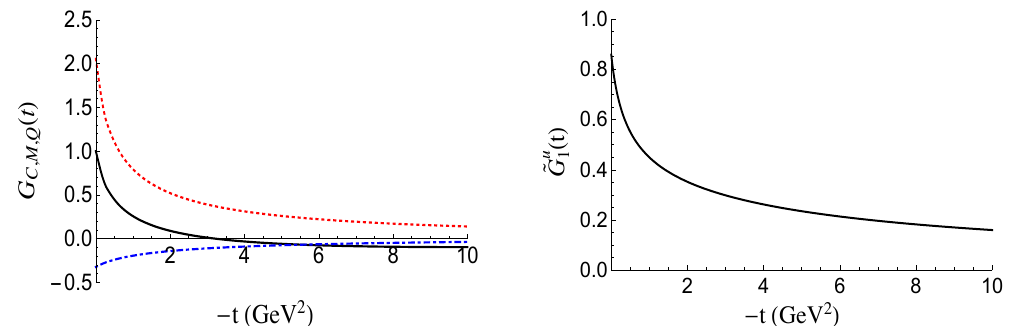
Figure 2: ρ meson form factors. (a) EM form factors, charge G magnetic G (dashed red curve), and quadrupole G M form factors, and (b) EW axial form factor ˜ G u